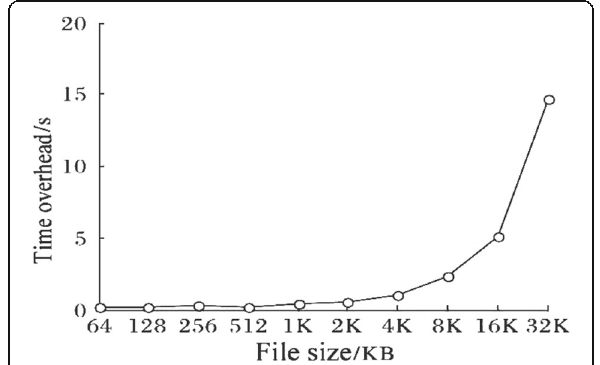
Fig. 7 The time cost of ownership proof based on BF.